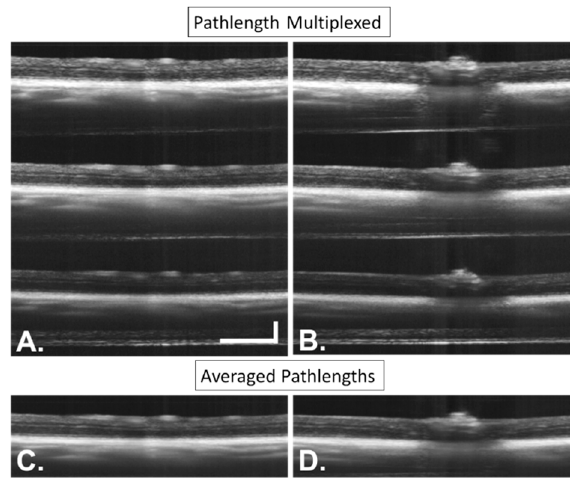
Figure 14. Sample SAR-OCT images ( A , B ) show cross-sectional images of the same mouse at two different B-scan locations. Pathlengths 1–3 are shown. Each pathlengths has been averaged to obtain images ( C , D ). Scale bars indicate 300 μ m.